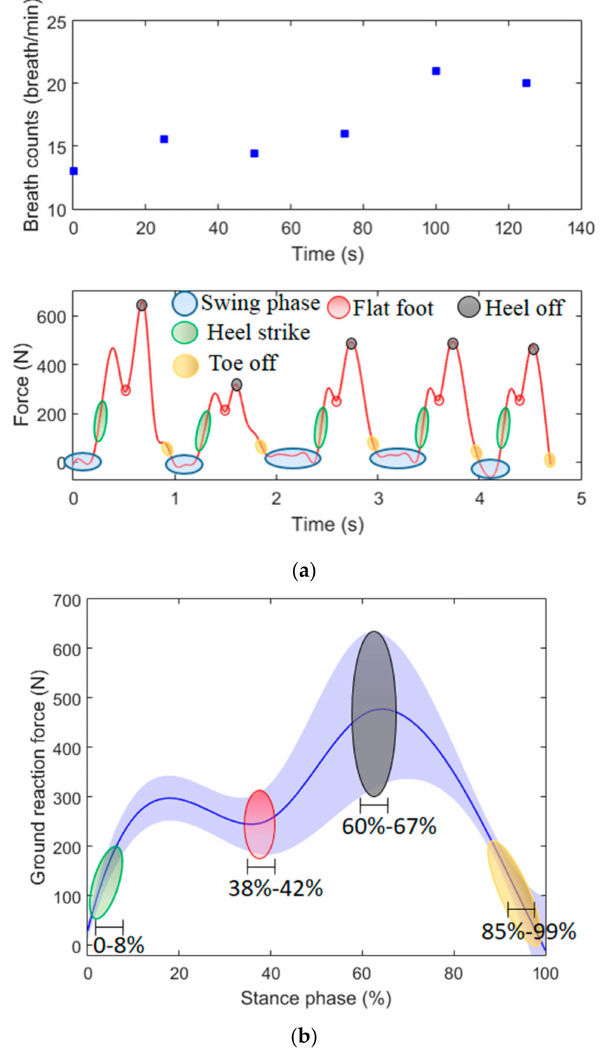
Figure 8. ( a ) Ground reaction force (GRF) and respiratory rate monitoring in gait cycles using POF-based sensor systems. ( b ) Mean (solid line) and standard deviation (shaded line) of the GRF estimated with the proposed insole for the tests in the third scenario. The intervals of the gait events detected are also